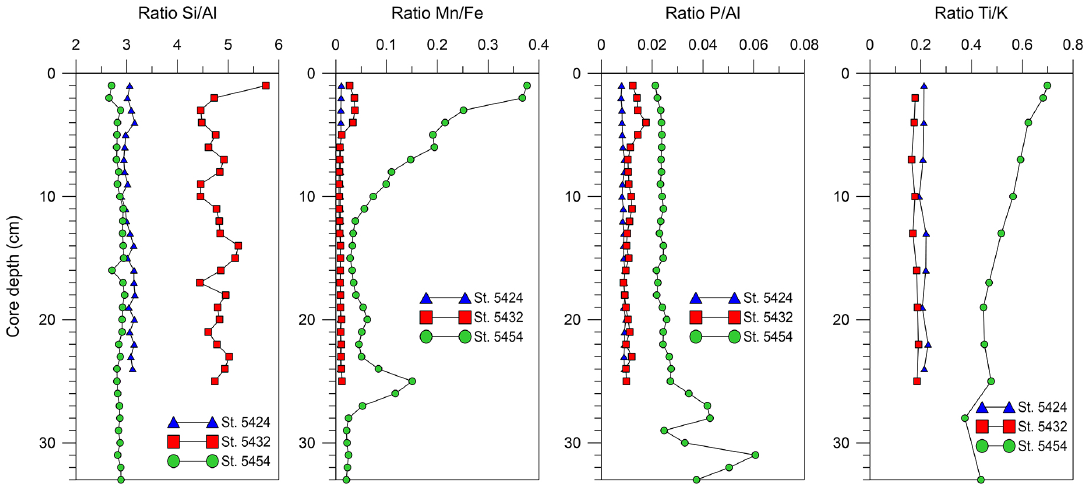
Figure 24. Comparison of selected elemental ratios in sediment cores, formed under di ff erent environmental conditions: AMK-5424, the Novaya Zemlya Archipelago; AMK-5432, the Bear Island Trough, and AMK-5454, the Franz Josef Land Archipelago. ( a ) Si / Al; ( b ) Mn / Fe; ( c ) P / Al; ( d ) Ti / K. Sediments in the Bear Island Trough (AMK-5432) with an increased proportion of